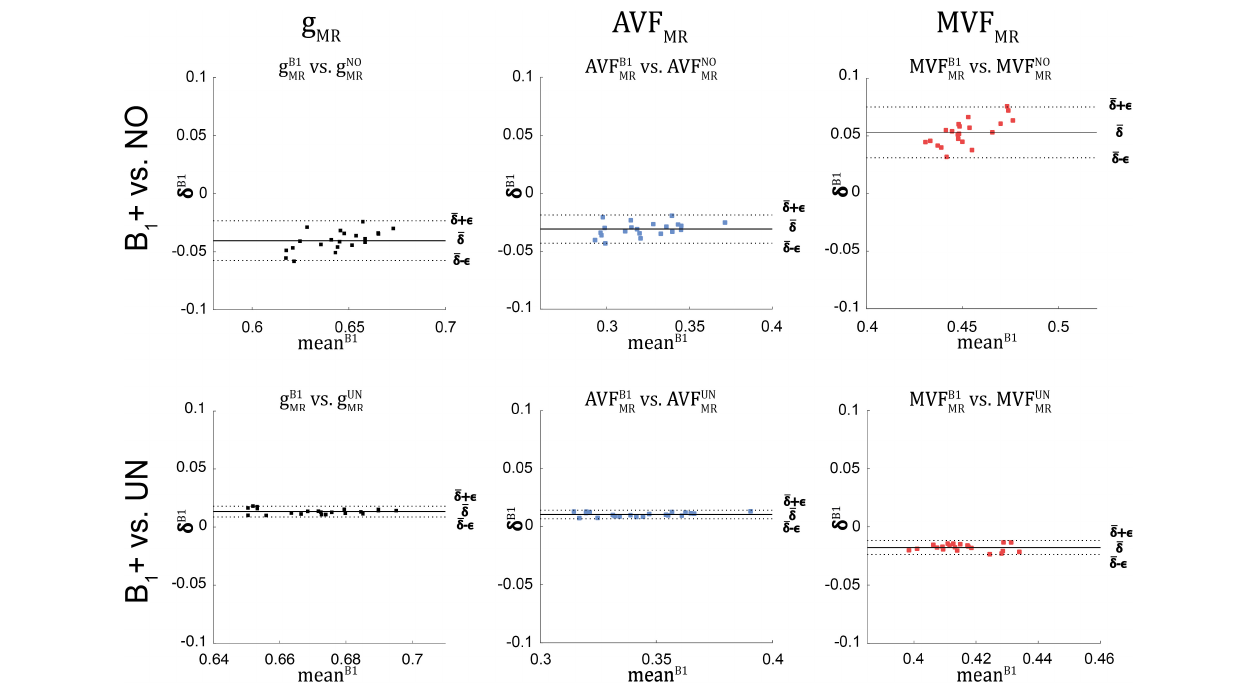
FIGURE 9 | Bland-Altman plots of g MR , AVF MR , and MVF MR , comparing values obtained without B 1 + correction (NO, top row) and with UNICORT B 1 + correction (UN, bottom row) against values obtained by B 1 + field map correction (superscript: B1). The Bland-Altman plot illustrates the differences between values obtained by two different methods (reference vs. tested method); e.g., δ B1 i = ( g B1 MR ) i − ( g k MR ) i against their mean (mean B1 i = ROI). Each point in the scatter plot represents the group-averaged value in a single ROI (see Figure 4 for the locations of the 21 high-SNR ROIs). The bold black